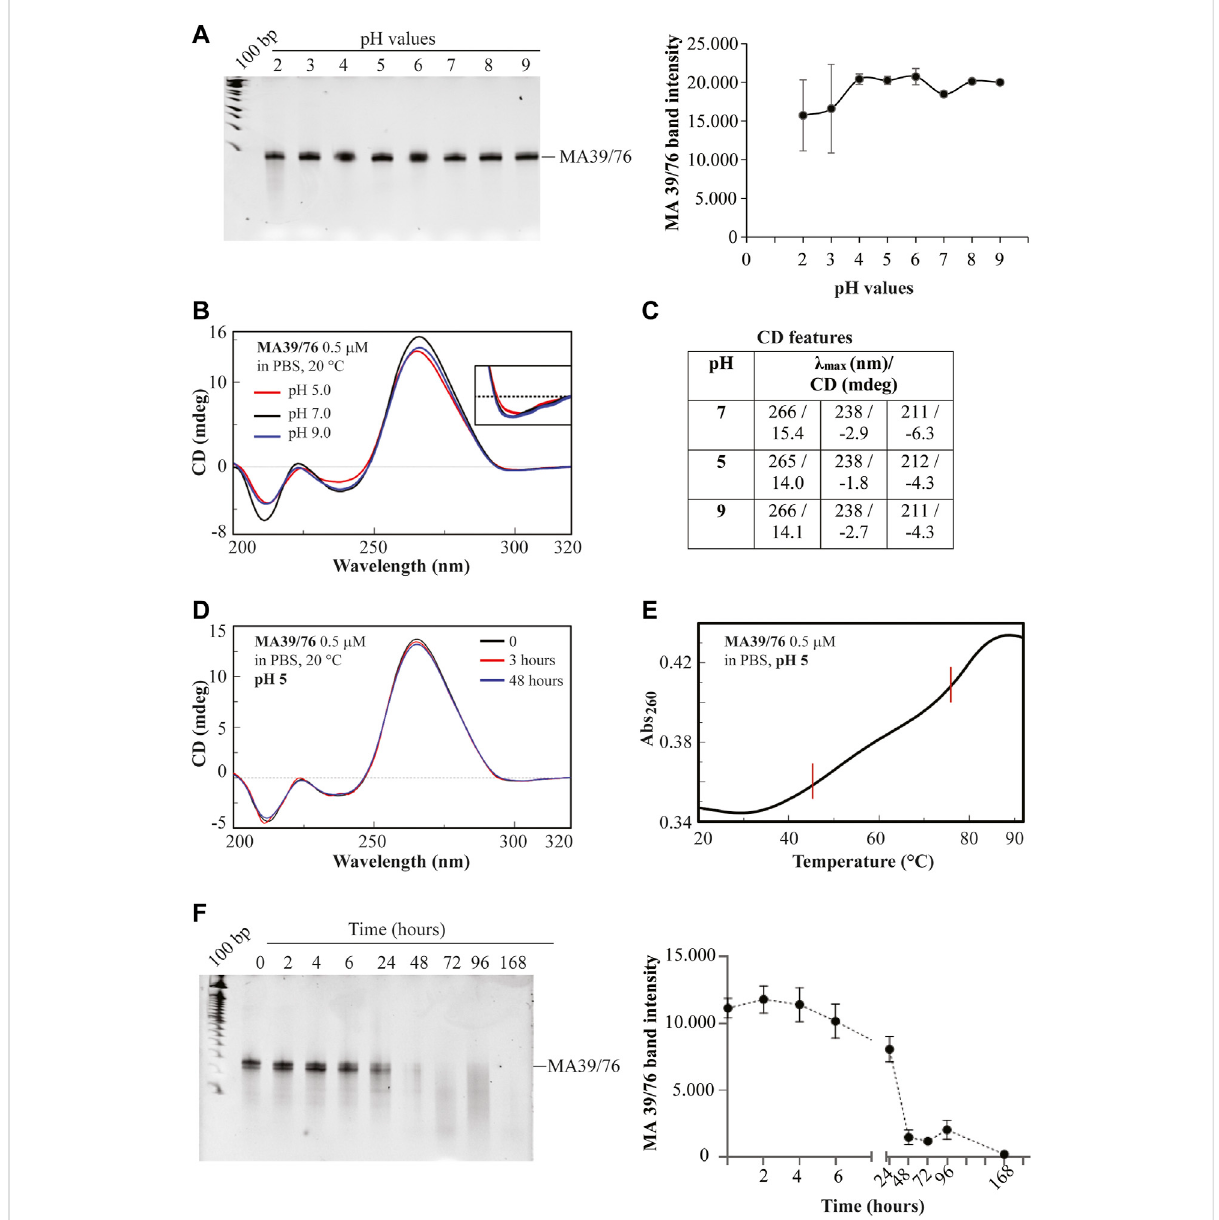
FIGURE 6 MA39/76aptamerstability. (A) pHstabilityofMA39/76wasmeasuredbyincubatingtheaptamerinbufferswithdifferentpH(2,3,4,5,6,7,8,9). RNA sequences wererecovered and subjectedto a15% denaturing polyacrylamide gel ( left panel ). After staining, bands were quanti fi edby using the ImageJ program. The pixel ofband intensity for each pHvalueisreportedinthegraph ( rightpanel ). (B) Overlapped CD spectra ofMA 39/76aptamer at 0.5 μ M concentration in PBS buffer at the indicated pH and (C) corresponding CD spectral features; (D) Overlapped CD spectra of the aptamerat0.5 μ Mconcentrationrecorded(20 ° C,1 cmquartzcuvette)immediatelyafterdilutioninPBSbufferatpH5(time=0),andafter3and48 h incubationat37 ° C. (E) UVmeltingcurveoftheMA36/76aptamerat0.5 μ MconcentrationrecordedinPBSbufferatpH5monitoringtheabsorbance at 260 nm upon increasing the temperature from 20 to 92 ° C (1 ° C/min; 0.5 cm quartz cuvette). (F) MA 39/76 serum stability was measured by incubating the aptamer at 4 μ M in 80% human serum for 0, 2, 4, 6, 24, 48, 72, 96, 168 h. RNA sequences recovered were subjected to a